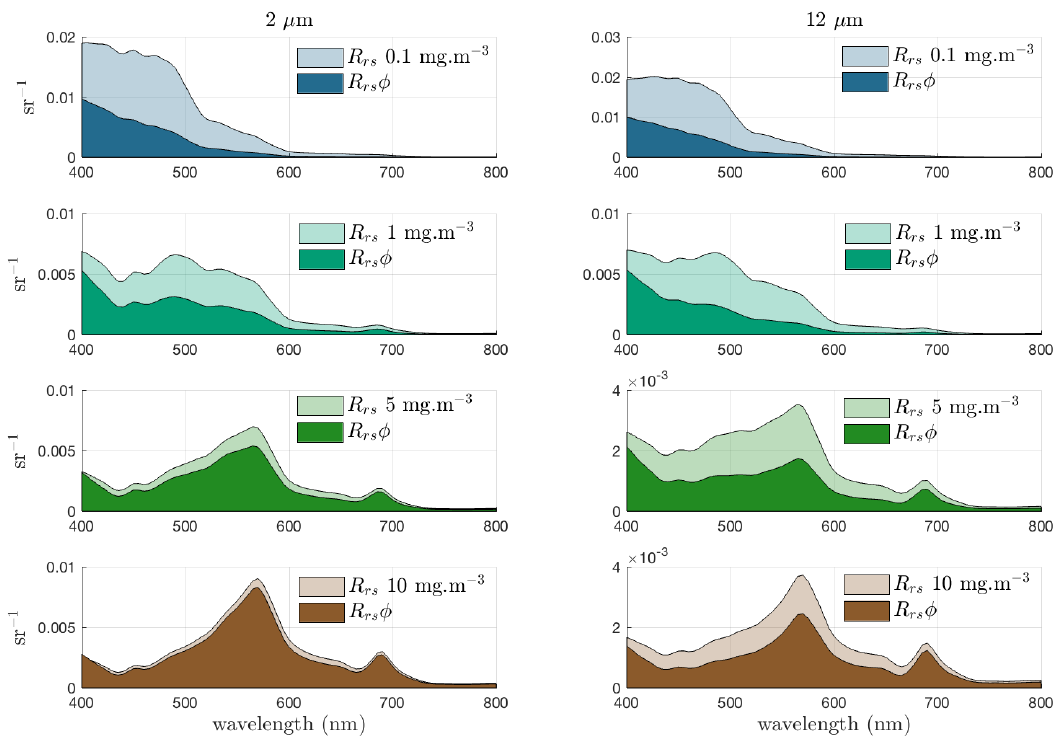
Figure 1. Relative contribution of phytoplankton to total R rs (with a gd ( 400 ) = 0.07 · [ Chl a ] 0.75 , and b bnap ( 550 ) = 0.005 m − 1 ) for increasing biomass with D ef f = 2 and 12 µ m. These populations are idealised examples and not intended to represent any observed relationship between Chl a concentration and D ef f